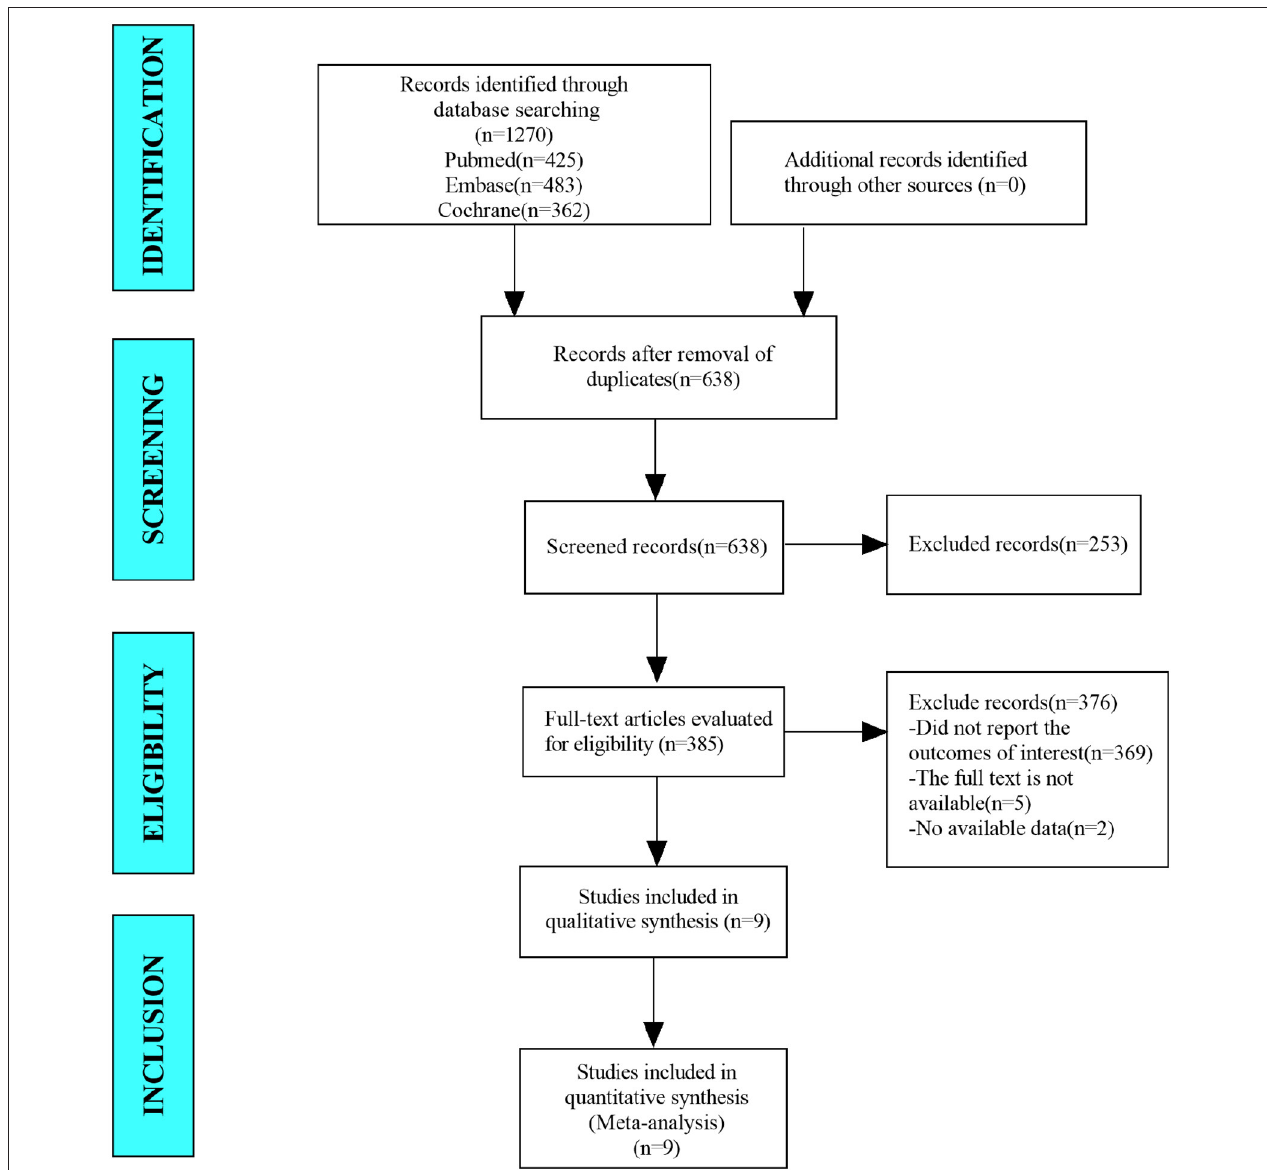
FIGURE 1 | Flow diagram for the selection of